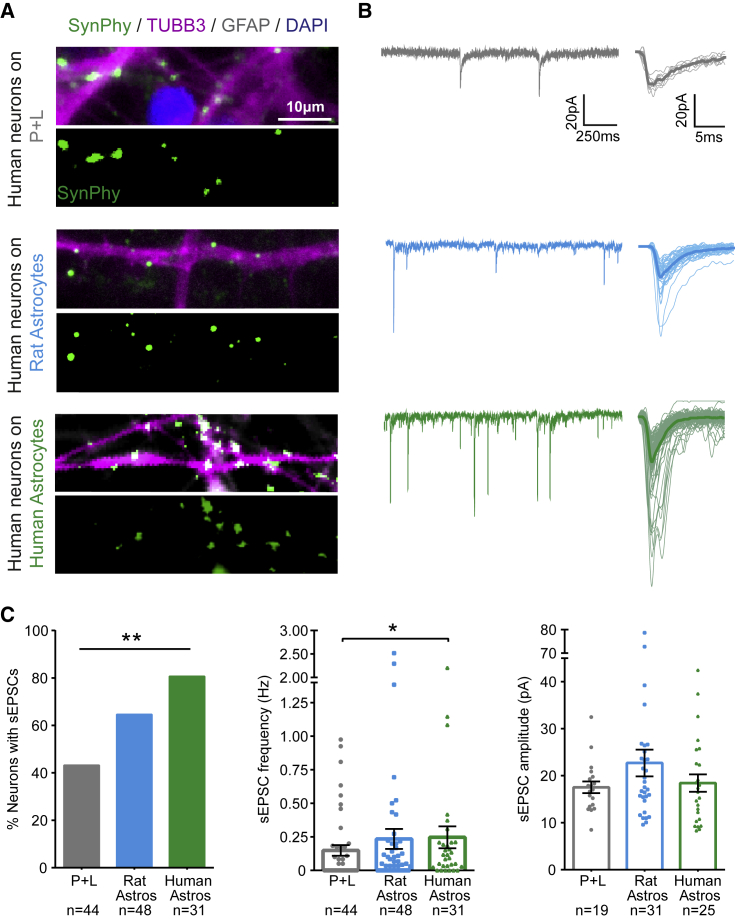
Co-culture with iPSC-Astrocytes Enhances Synaptic Networks among Cortical iPSC-Neurons(A) Example immunofluorescence images showing putative synaptophysin-positive (SynPhy+) pre-synaptic connections overlapping with TUBB3+ neuronal processes in the three culture conditions: on polyornithine and laminin-coated coverslips (P + L, neurons 73 days; top), as co-cultures with rat astrocytes (neurons 62 days, co-cultured for 22 days; middle), or as co-cultures with human iPSC-astrocytes (neurons 80 days, astrocytes 104 days, co-cultured for 37 days; bottom).(B) Example whole-cell patch-clamp recordings of sEPSCs across the three culture conditions. An individual trace is shown (left) and overlays of detected sEPSCs (right), with the average sEPSC in bold.(C) Population data showing the proportion of neurons receiving sEPSCs (left), the frequency of sEPSCs (middle), and amplitude of sEPSCs (right) across the three culture conditions. Sample sizes represent individual neurons recorded from 13 cultures across three cell lines (P + L neurons: 92 ± 3.3 days), 12 cultures across two cell lines (on rat astrocytes: neurons 93 ± 4.9 days, co-cultured for 51 ± 2.9 days), and five cultures across two cell lines (on human astrocytes: neurons 84 ± 7.6 days, astrocytes 120 ± 9.5 days, co-cultured for 44 ± 7.7 days). ∗p < 0.05, ∗∗p < 0.01.